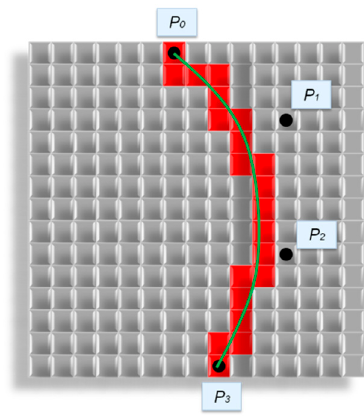
Figure 12. Creation a fiber with Bezier curve: —“fiber” cells, —“empty” cells, • —control points, —Bezier curves. Figure 11. Cross-section of a digital representation of a 14 nm fiber with a 2nm cell scale. Initially, the control points P (cid:2868) , P (cid:2869) , P (cid:2870) and P (cid:2871) are randomly selected on the field, P (cid:2868) and P (cid:2871) lie on one of the edges of the field. A Bezier curve is constructed from these control points in accordance with (1). Bezier curve passes through the points P (cid:2868) and P (cid:2871) and does not pass through points P (cid:2869) and P (cid:2870) . Cells which lie on the curve pass are set into "fiber" state (Figure 13). Further, the fiber diameter increases until it reaches the specified one. New fibers are generated until the structure reaches the specified porosity.